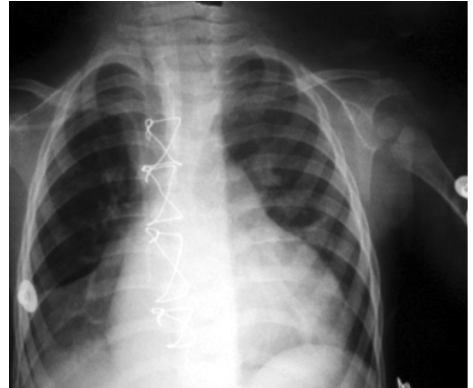
Fig. 2 - Radiograma de tórax em posição póstero-anterior, no 16º dia de pós-operatório, com plena resolução da atelectasia basal à